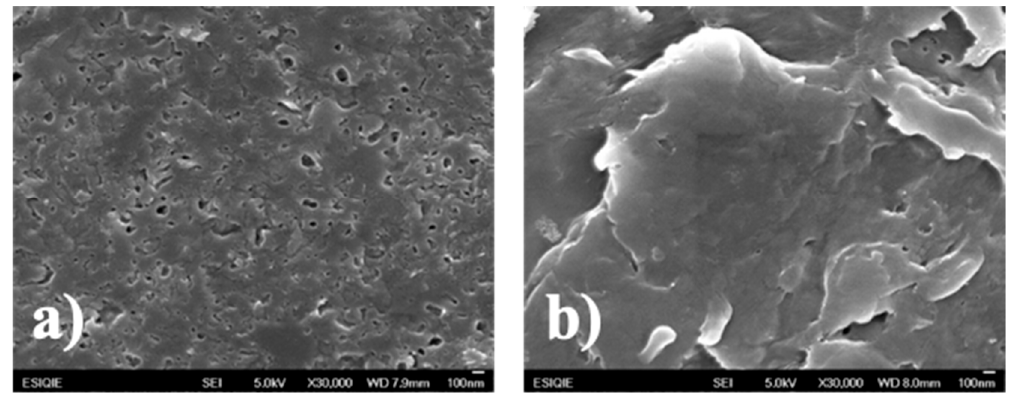
Figure 6. Scanning electron microscope (SEM) images of ( a ) PS/2MgZnAl-AAC (15 wt.%) and ( b ) PS/Mg2ZnAl-AAC (15 wt.%).